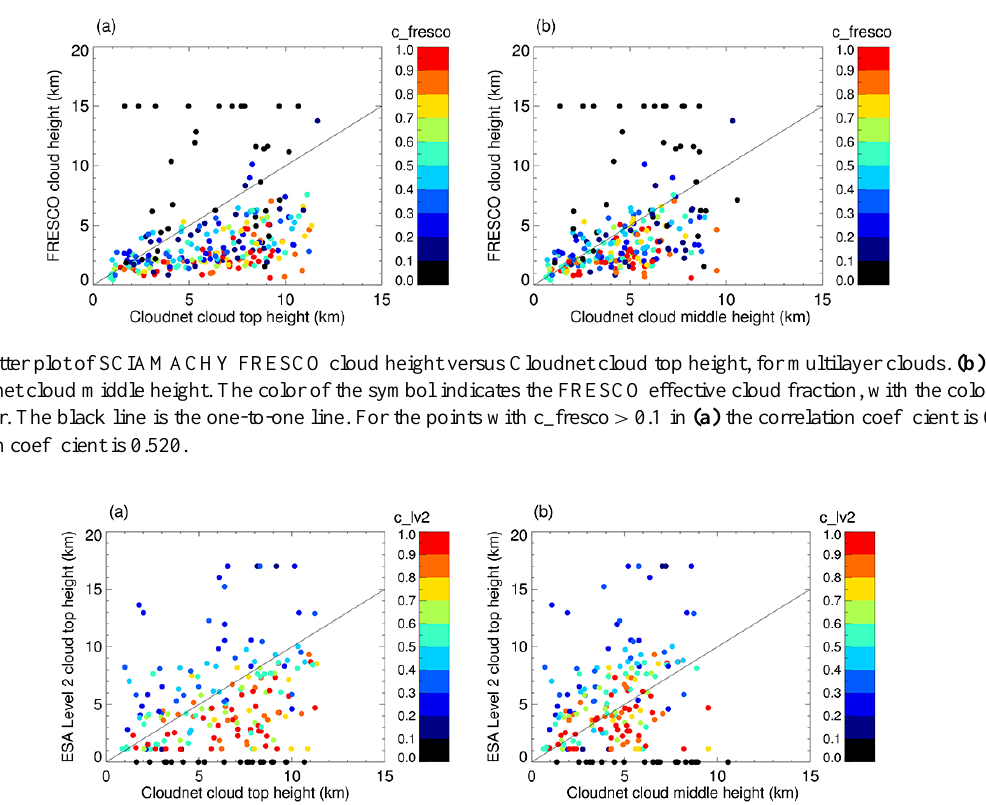
Figure 10. (a) Scatter plot of ESA L2 cloud top height versus Cloudnet cloud top height, for multilayer clouds. (b) Same as (a) but versus Cloudnet cloud middle height. The color of the symbol indicates the ESA L2 cloud fraction, with the color code given by the vertical bar. The black line is the one-to-one line. For the points with c_lv2 > 0.1 in (a) the correlation coefficient is 0.330 and in (b) the correlation coefficient is